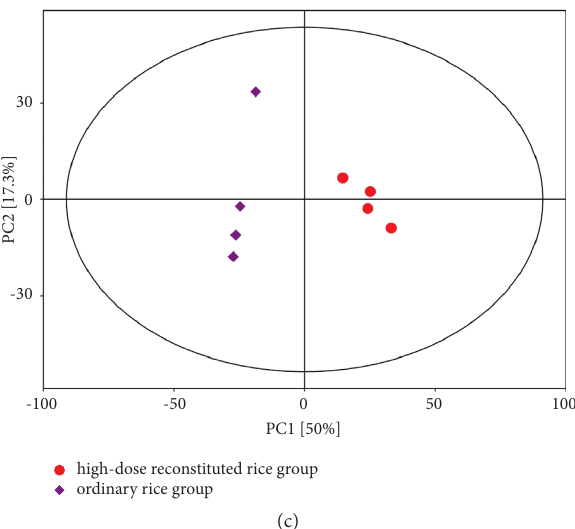
Figure 2: PCA analysis of blood samples from rats under different feedary interventions (negative ion mode). (Remarks: (a) high-dose reconstituted rice group vs. high-fat feed group; (b) high-fat feed group vs. ordinary rice group; and (c) high-dose reconstituted rice group vs. ordinary rice